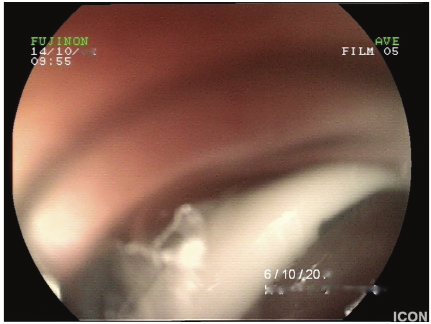
Figure 2: Duodenal erosion by the connection